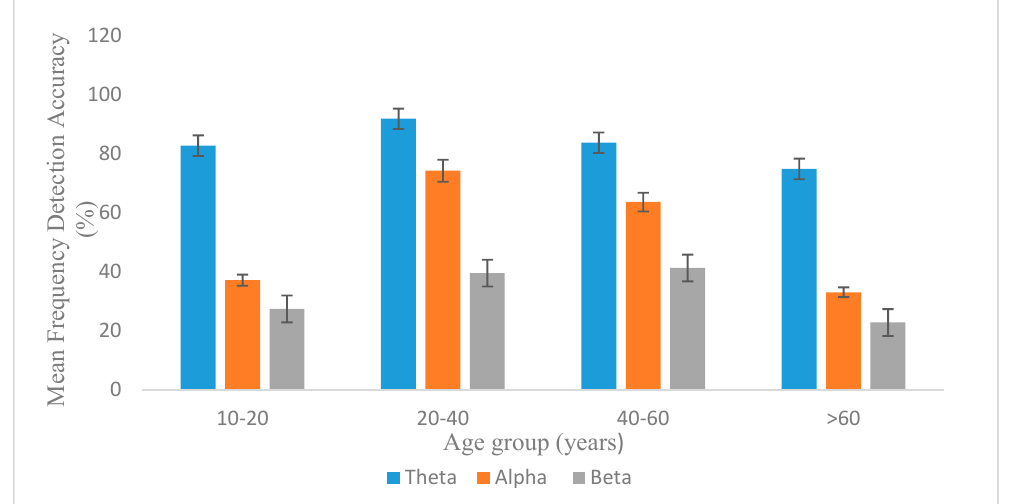
Figure 4. Mean detection accuracy of theta, alpha, and beta stimulus frequencies in SSVEP signals pertaining to varying age groups.